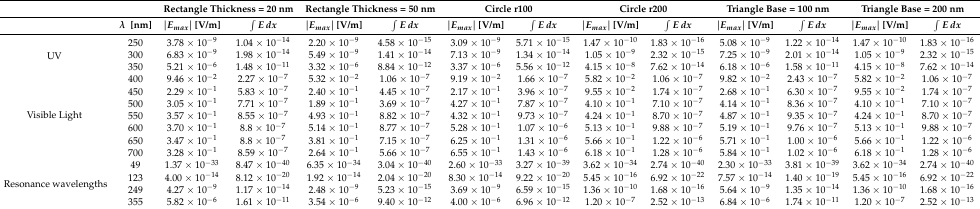
Table A2. Summary table of the results obtained for the silver nanostructures—Probe 2.